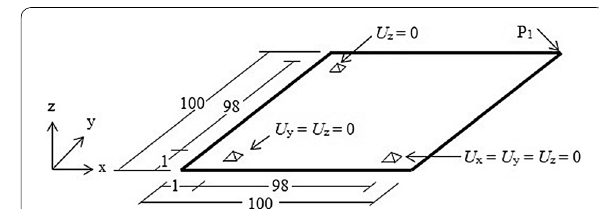
Fig. 3 Sample of sealing specimen